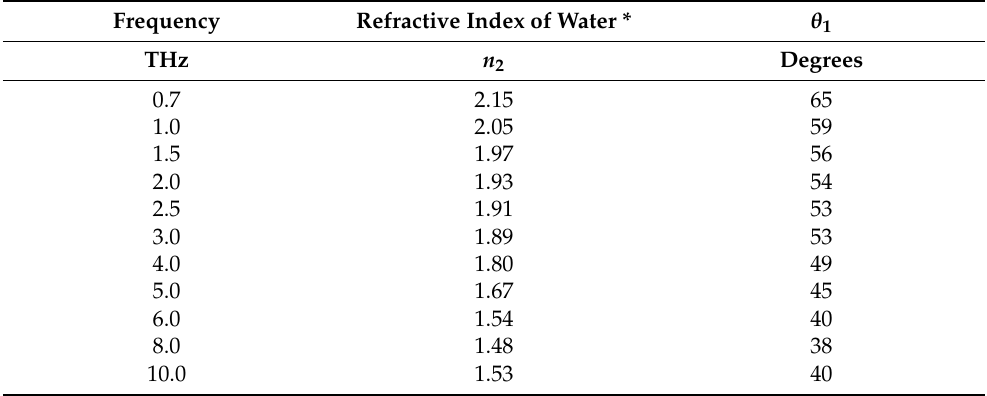
Table 1. Calculated angle for θ 1 of boundary between “true” ATR and PTPR modes of water with a diamond crystal ( n 1 =